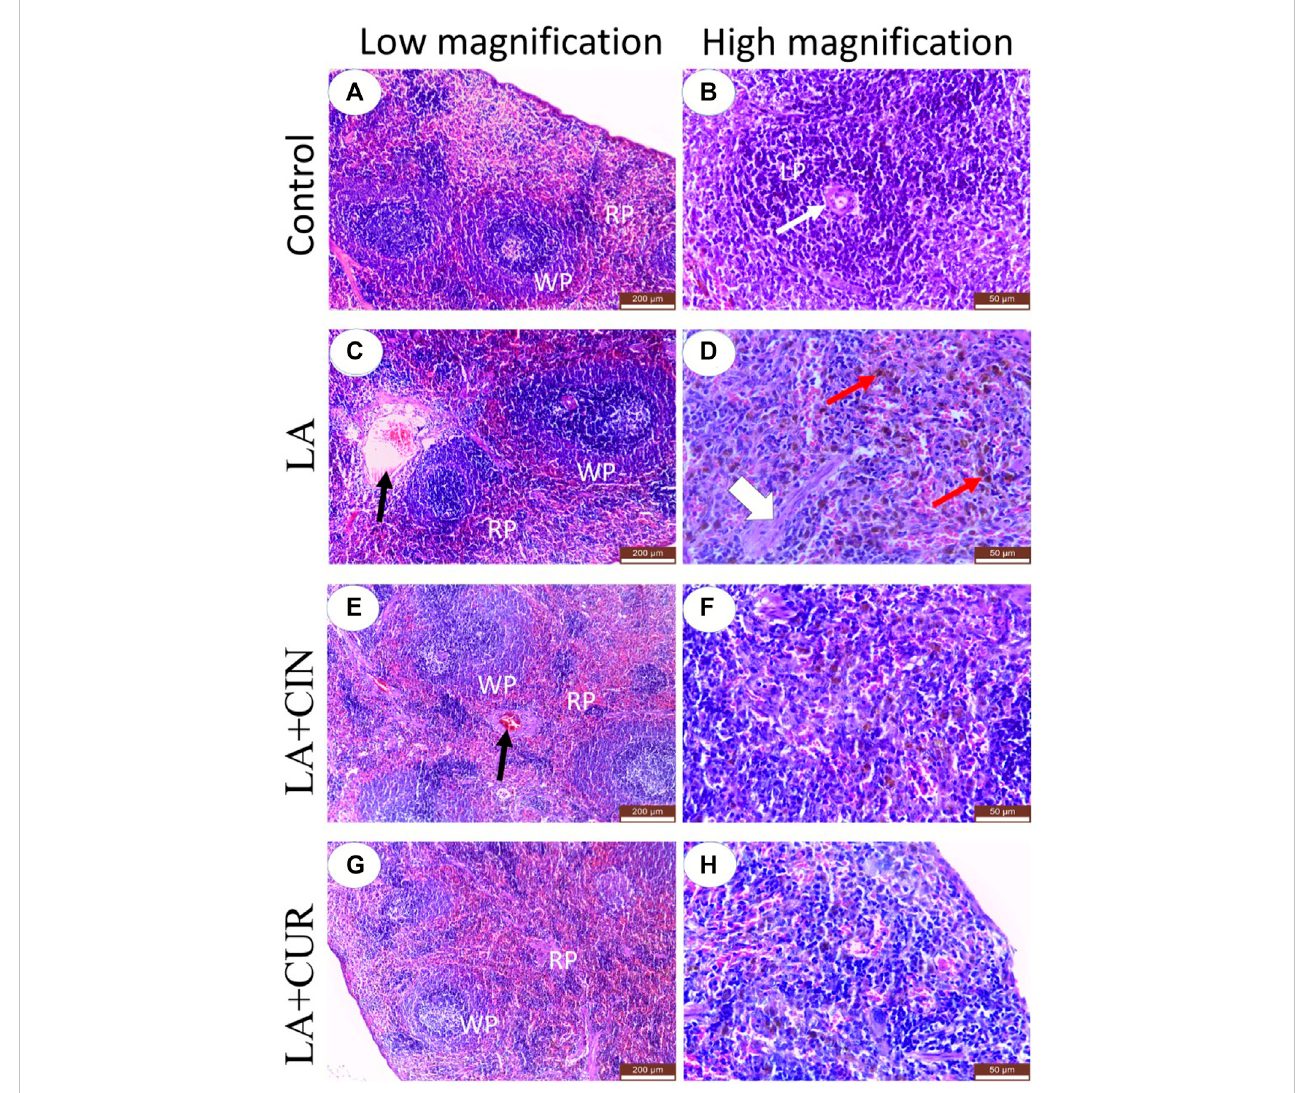
FIGURE 8 H&E-stained sections of the spleen from adult Albino rats, (A) control, (C) LA, (E) LA + CIN, and (G) LA + CUR groups. (B) , (D) , (F), and (H) were higher magni fi cationofcontrol,LA,LA+CIN,and (G) LA+CURgroups,respectively.Redpulp(RP),whitepulp(WP),lymphoidfollicle(LP),centralarteriole(thinwhite arrows), blood vessels (black arrows), septa (broad white arrow), and hemosiderin pigments (red arrows). H&E